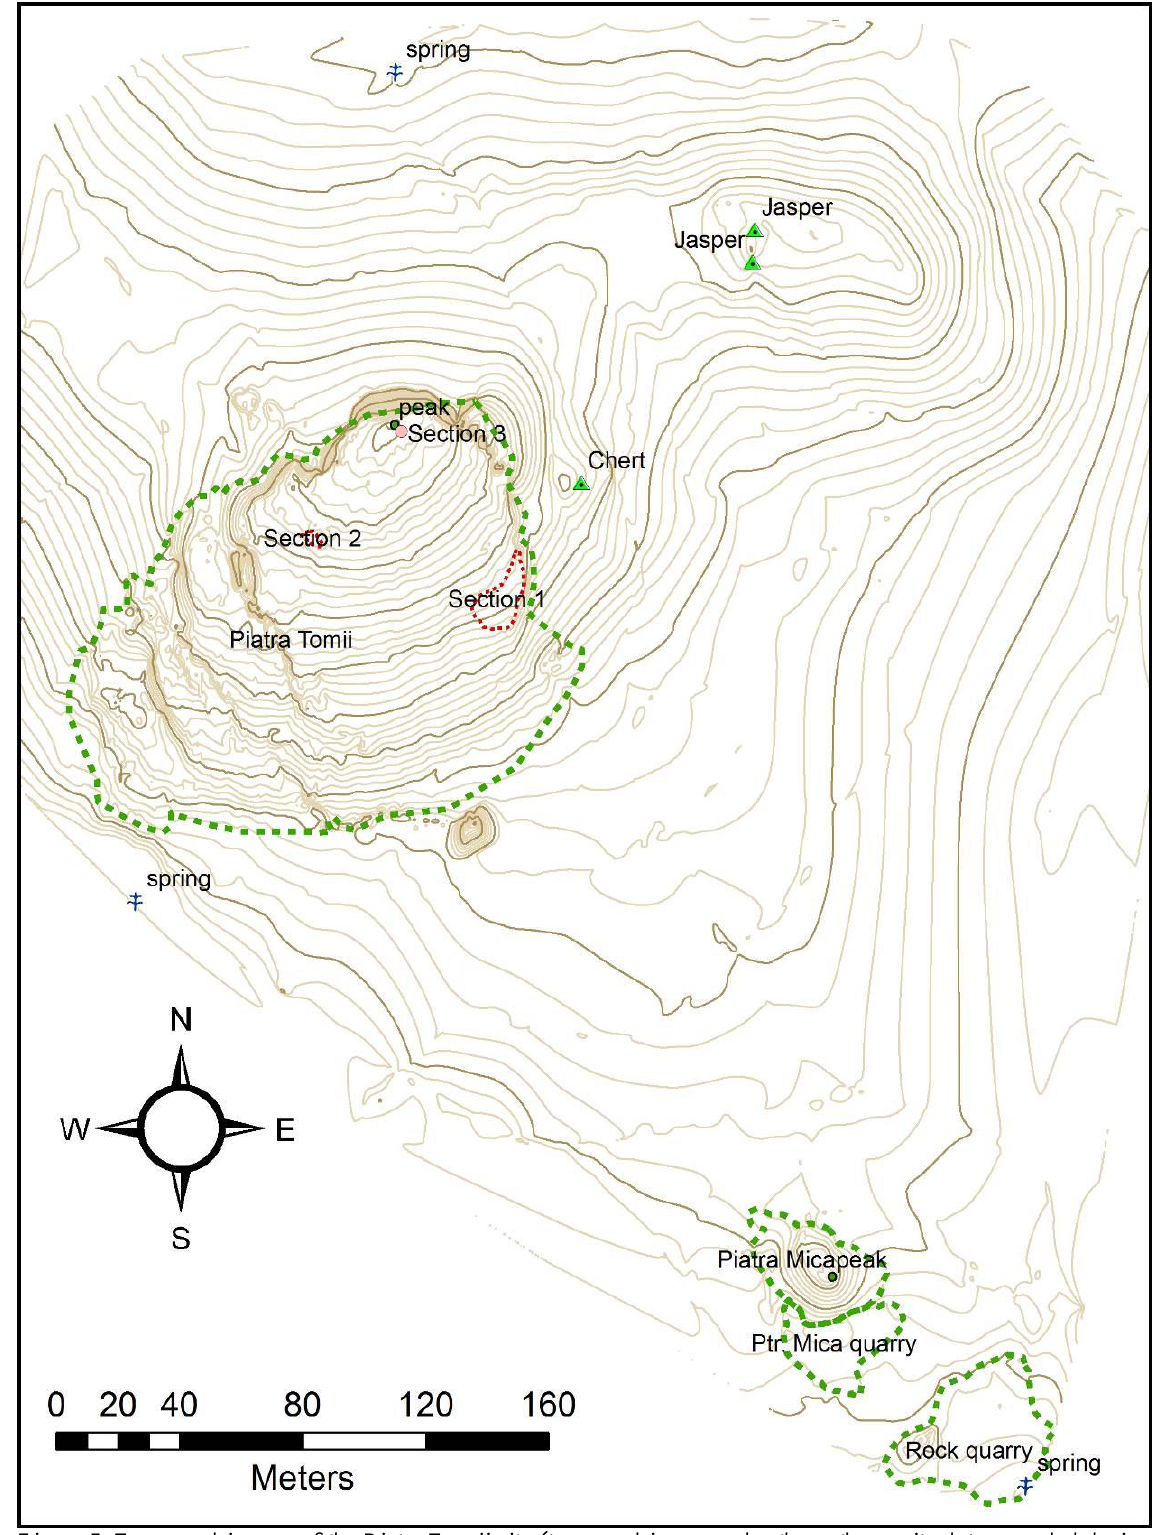
Figure 5. Topographic map of the Piatra Tomii site (topographic survey by the authors, site data recorded during the 2009 excavation and previous field walking surveys). The areas marked by green dashed line represent the main physical features around the